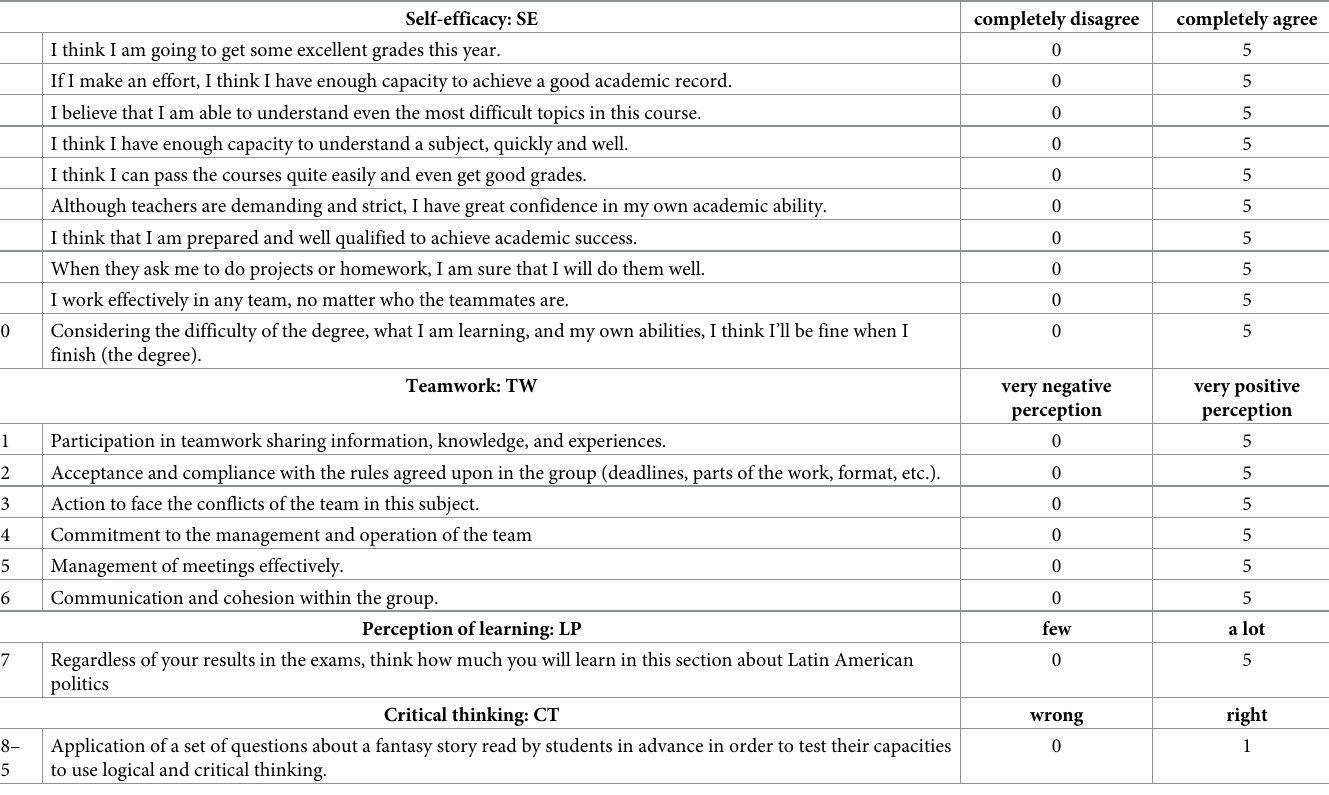
Table 1. 25-question survey items about soft skills.